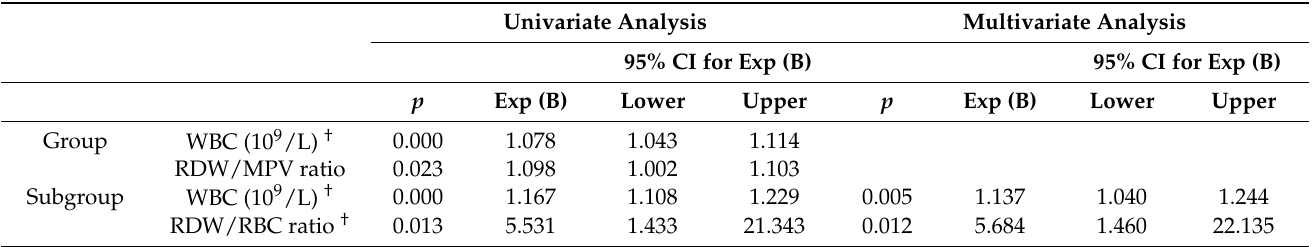
Table 2. Logistic regression analysis between groups and subgroup. Univariate Analysis Multivariate Analysis